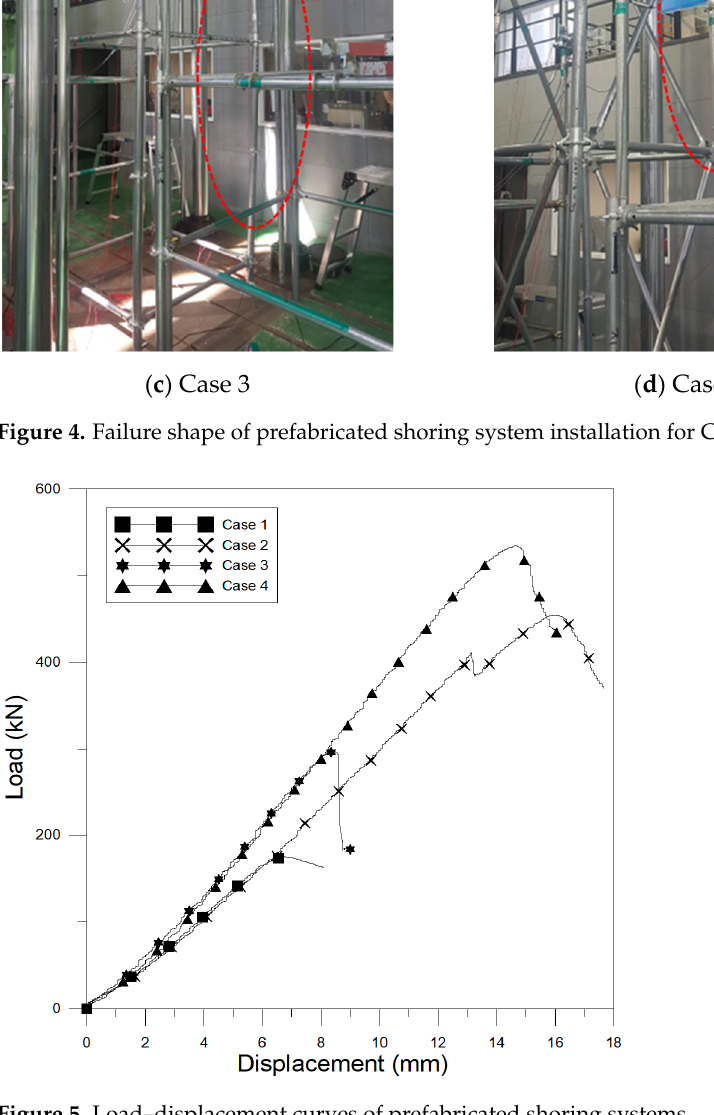
Figure 5. Load–displacement curves of prefabricated shoring systems. Table 6. Ultimate loads of prefabricated shoring systems and vertical displacements at the maximum compressive loads.